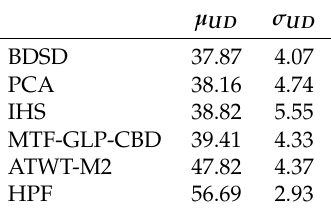
Table 18. Means ( µ UD ) and standard deviations ( σ UD ) of DMOS GM for each PS technique extracted from 30 PS undistorted images (6 PS algorithms) in five different scenarios). The PS techniques are organized from high to low